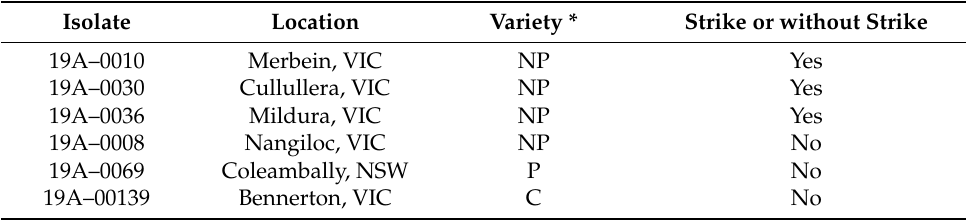
Table 1. Rhizopus stolonifer isolates used in this study, the almond variety and location that they came from, and the type of disease symptom they were associated with. Isolate Location Variety * Strike or without Strike 19A–0010 Merbein, VIC NP